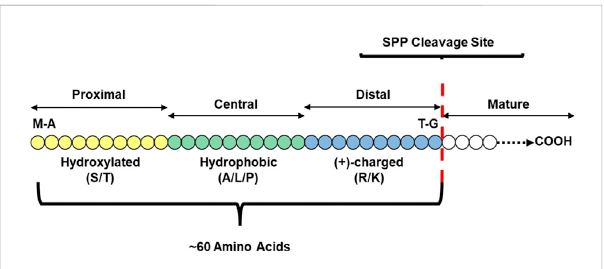
FIGURE 1 Basic Transit Peptide Structural Model. The three major domains required for a functional transit peptide include a hydroxylated N-terminus (N-domain) for binding to cytosolic and stromal chaperones, a hydrophobic, uncharged central domain responsible for bridging the outer and inner envelopes, and a positively-charged C-terminus that interacts with TOC GTPases to stabilize early translocation intermediates and ultimately trigger full translocation. Some elements may be repeated or be present in only some transit peptides, such as acidic residues at the C-terminus that may confer selectivity for certain TOC